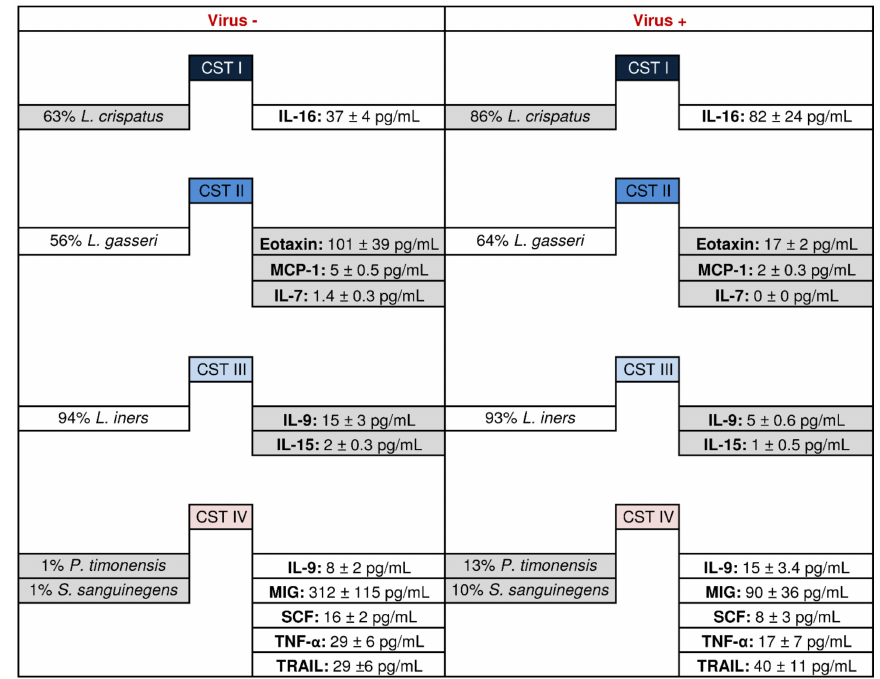
Figure 4. The impact of viruses on the CSTs. The figure shows the significantly modulated aspects between viral DNA negative vs. positive samples within each CST ( p value < 0.05). Mixed CST and Bifidobacteria groups are missing as the first group did not show viral DNA while the latter had only one sample positive for viral DNA. Microbial di ff erences were calculated by means of a non-parametric T-test for pairwise comparisons among CSTs using QIIME 1.9.1 while immunological di ff erences were calculated using GraphPad Prism v. 5. The grey cells highlight the significant